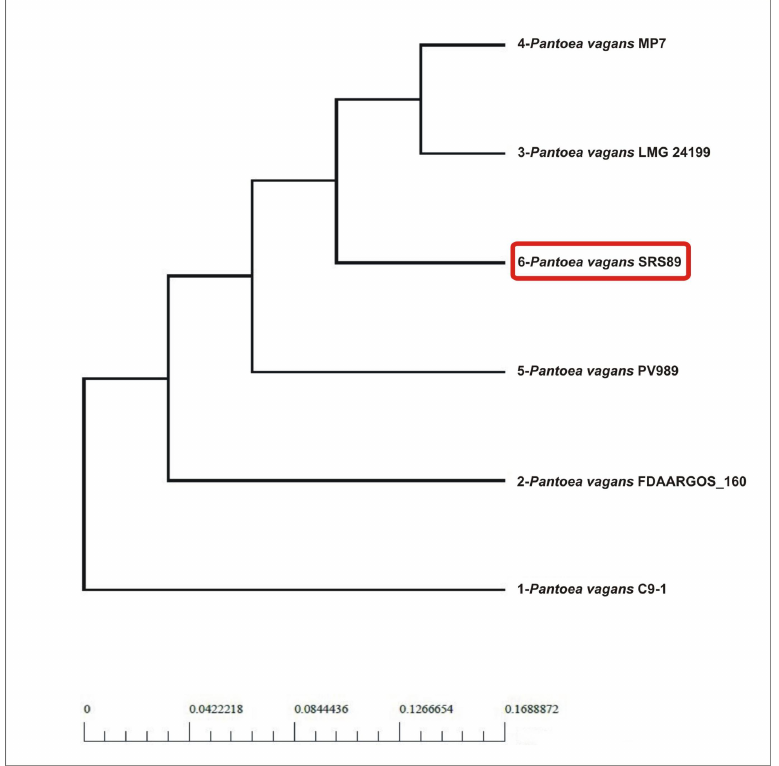
Figure 4. Phylogenetic analysis the selected Pantoea vagans strains based on pan- and core-genome analysis.